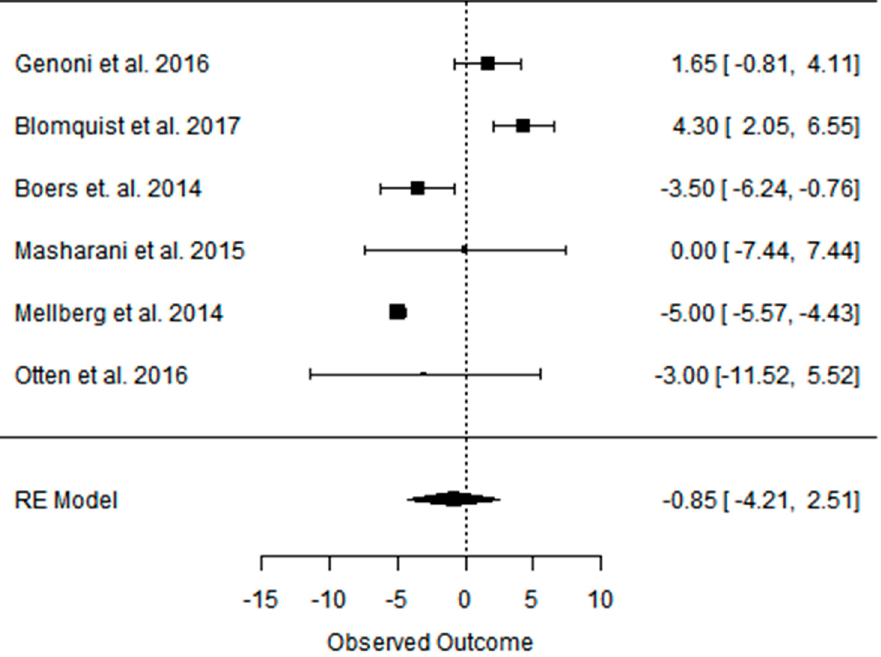
Figure A39. Forest plot of the effect of a CD on DBP in the short term (weighted mean difference).